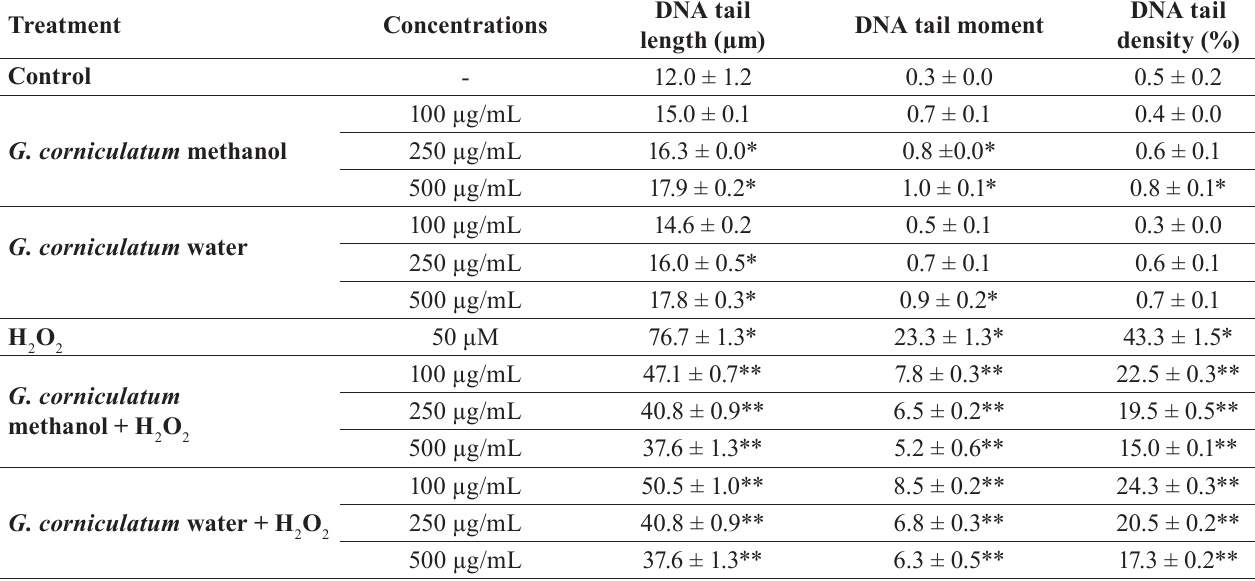
TABLE II - Genotoxic and antigenotoxic effects of G. corniculatum extracts on human